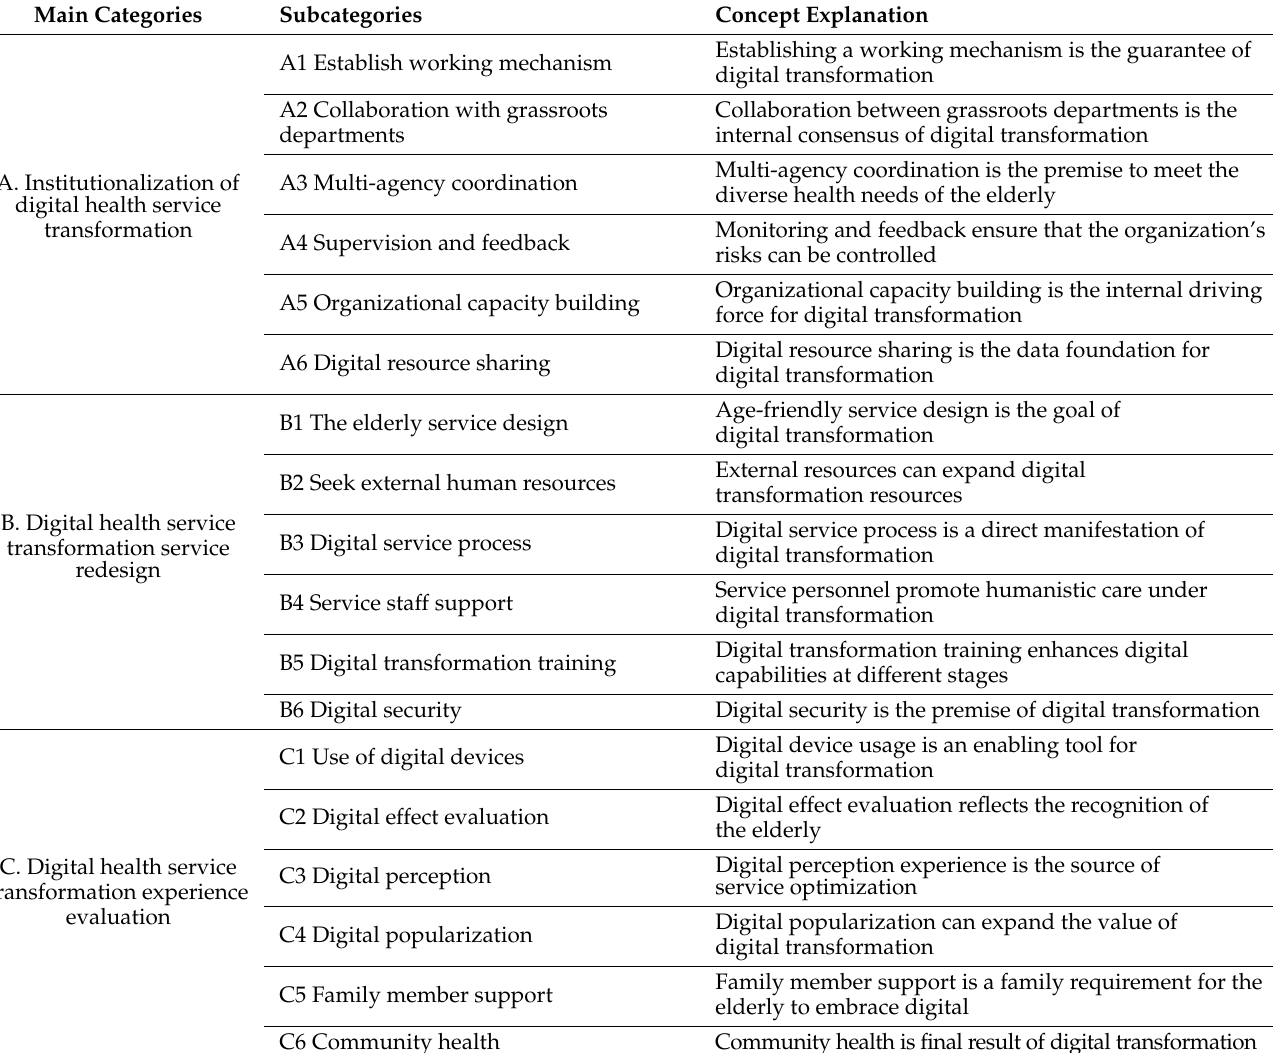
Table 8. The categories and relational connotations of the axial